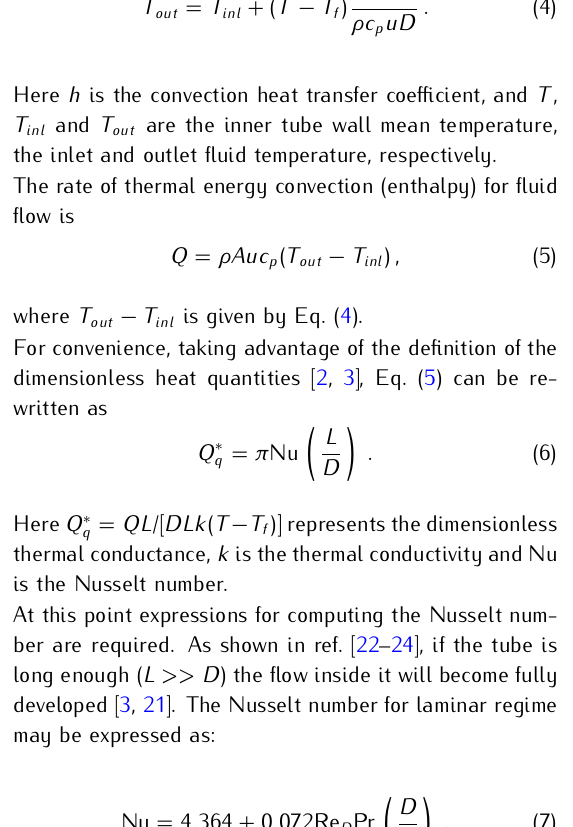
In order to solve Eq. (1) boundary conditions are needed along the tube walls. Walls may be maintained at a con- stant temperature or under constant heat